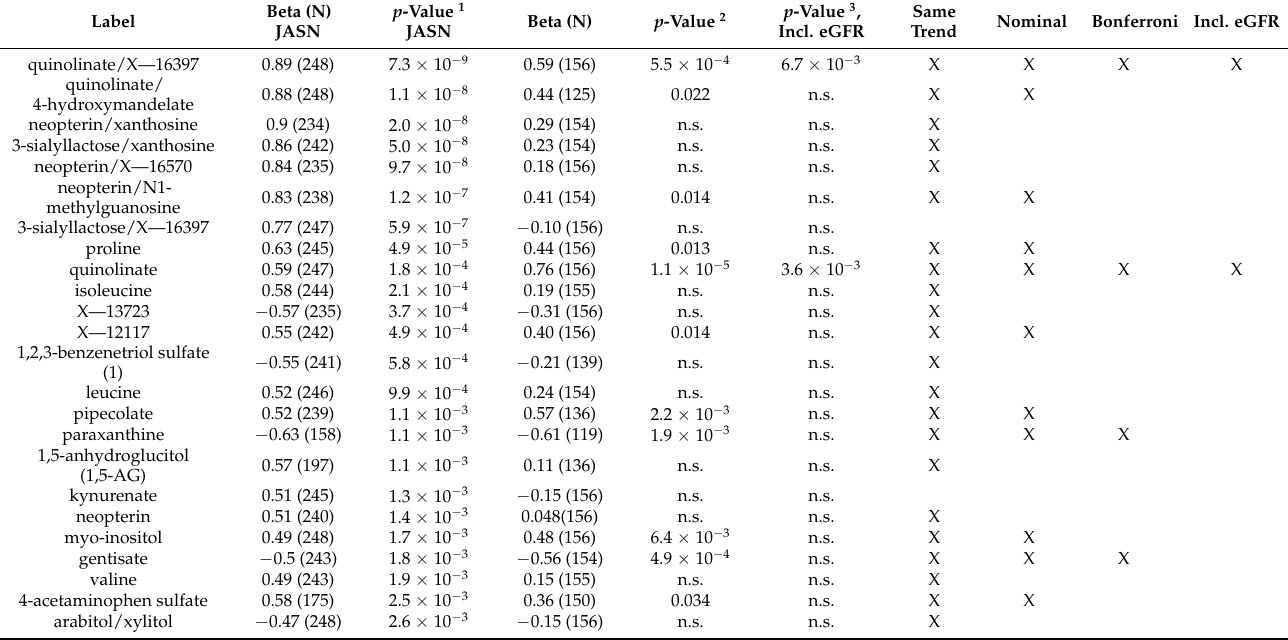
Table 2. Replication of associations reported in [3]. Associations displaying identical directionality of the association with acute rejection (same trend), nominal ( p -value < 0.05) or Bonferroni ( p -value < 0.05/24) significance, and nominal significance after accounting for eGFR as a co-variate are marked by a cross